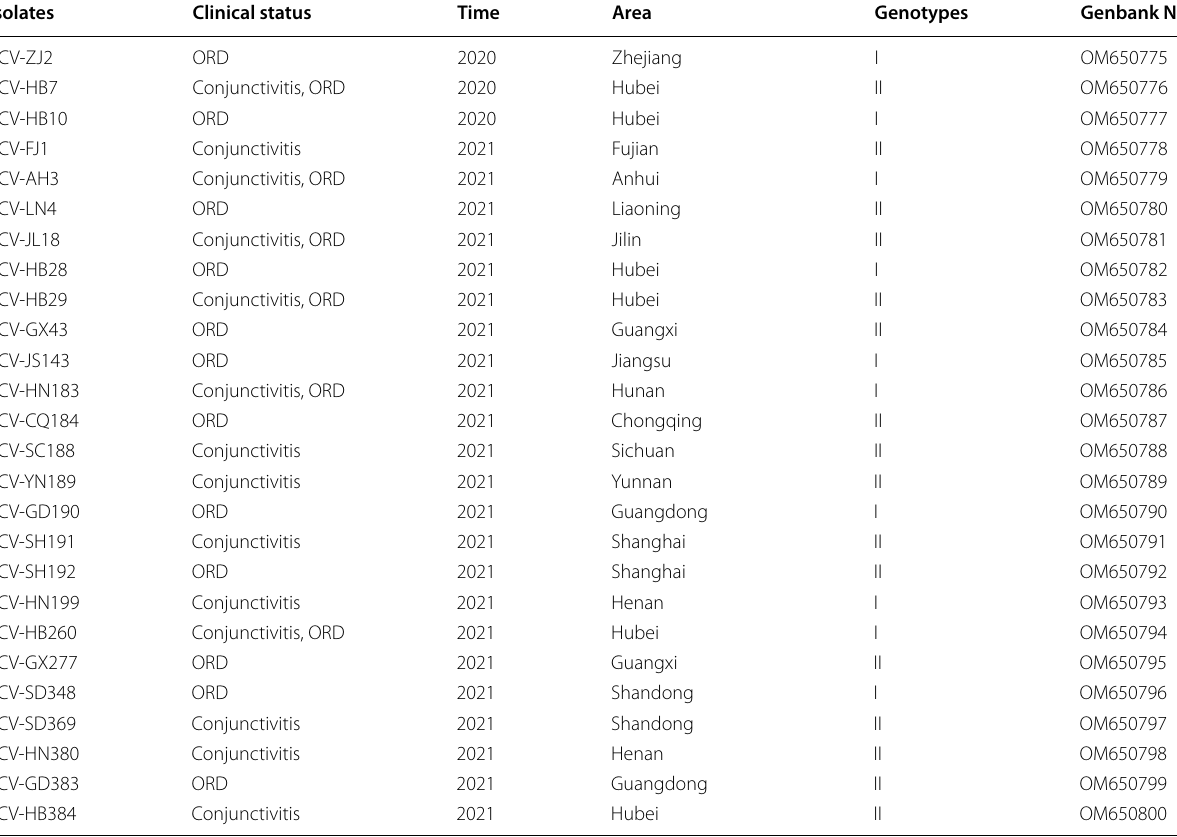
ORD oral respiratory disease